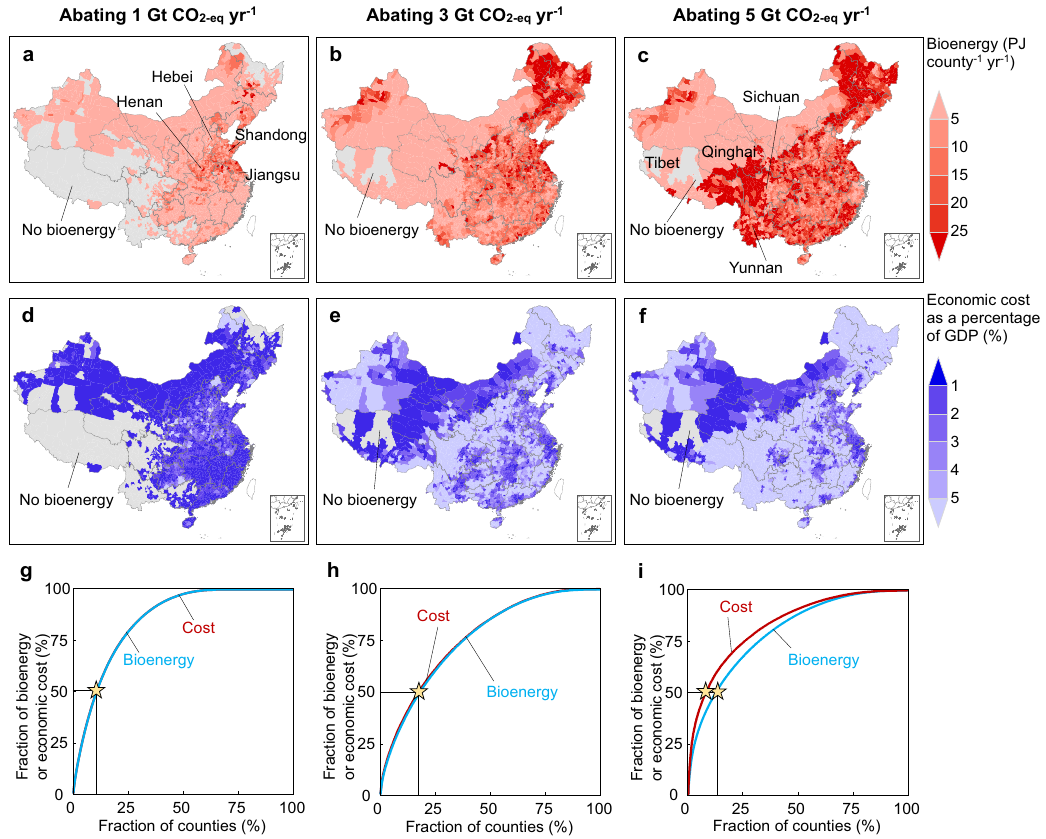
Fig. 5 Spatial distributions of bioenergy production and economic costs of BECCS. a – c Bioenergy production or d – f economic costs as a percentage of GDP in 2015 by county to abate net emissions of 1, 3, and 5 Gt CO 2-eq year − 1 by BECCS in China, respectively. g – i Distributions of the bioenergy (blue) and economic costs (red) across 2836 counties in China. The stars show where 50% of bioenergy is